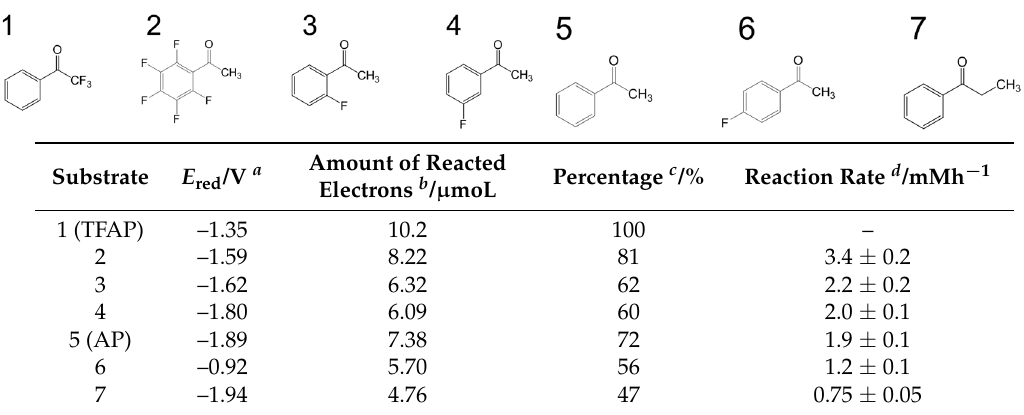
Table 1. Reduction potentials, amount of reacted electrons, percentages of reacted electrons, and reaction rates at maximum concentration of substrates [72]. Adapted with permission from reference [72]. Copyright (2014) The Royal Society of Chemistry.